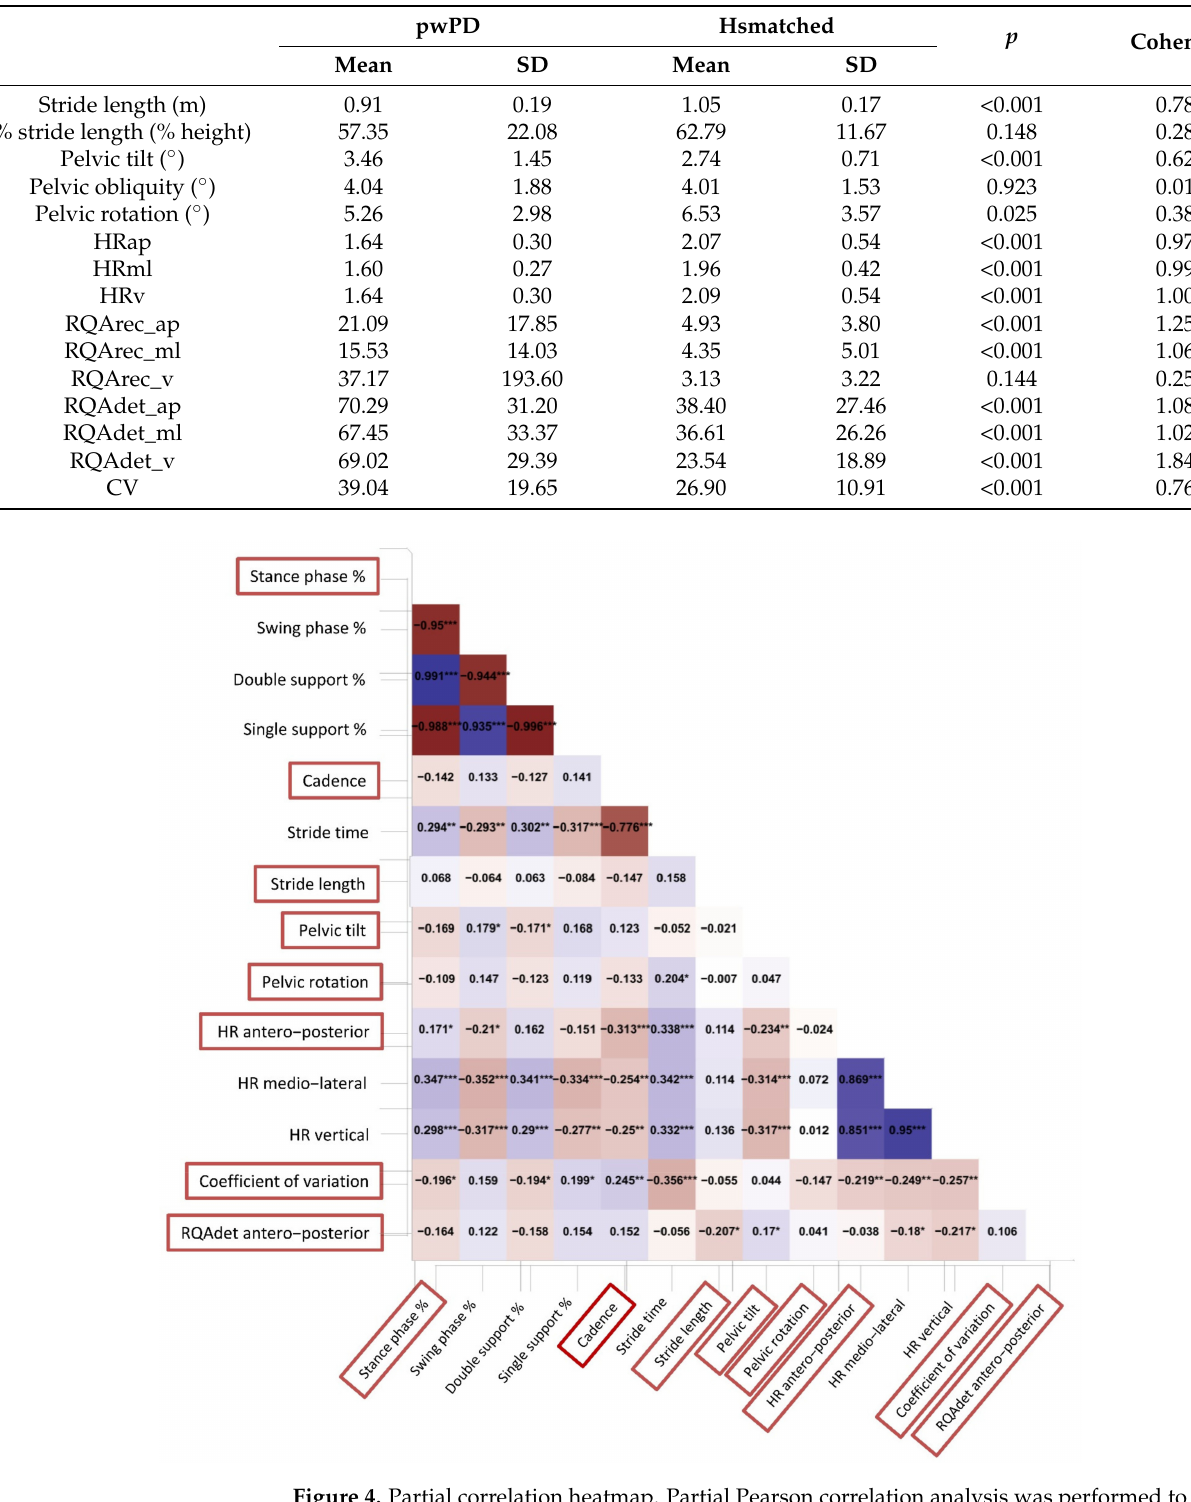
Figure 4. Partial correlation heatmap. Partial Pearson correlation analysis was performed to evaluate relationships among the initial set of features. A heatmap of the dataset’s characteristics showed dif- ferent Pearson coefficients for every single variable. The deeper the red or blue color, the stronger the negative or positive correlation, respectively. In the decision process, we reduced the dimensionality of dataset according to the choice of which parameter we could keep that showed a partial correlation value ≥ 0.50 to prevent multicollinearity issues: *, p < 0.05; **, p < 0.01; ***, p <